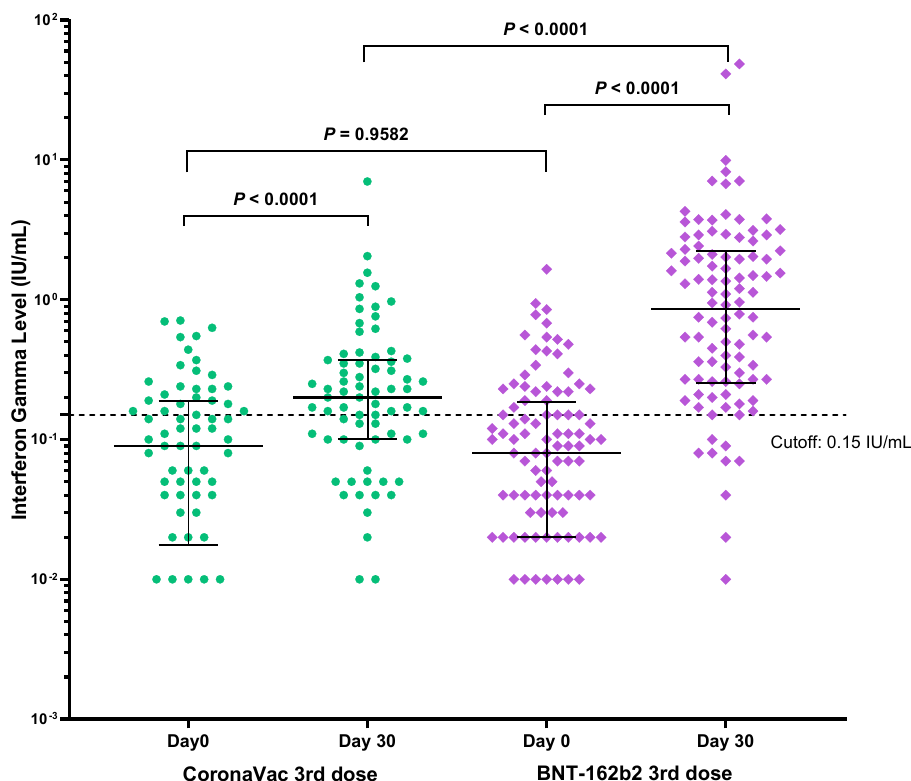
Figure 4. Comparison of immunogenicity of CoronaVac and BNT162b2 booster vaccination by QuantiFERON SARS-CoV-2 (IGRA). Median and p -values were tested using a Mann-Whitney test (By Prism GraphPad Software). Table 4. QuantiFERON-SARS-CoV-2 positivity before and after CoronaVac and BNT162b2 booster.